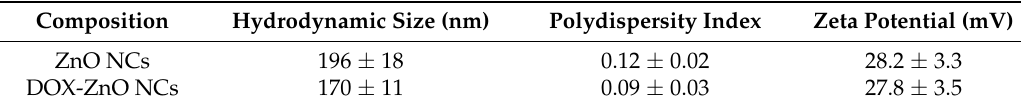
Table 1. Particle characterizations of NCs ( n = 3).